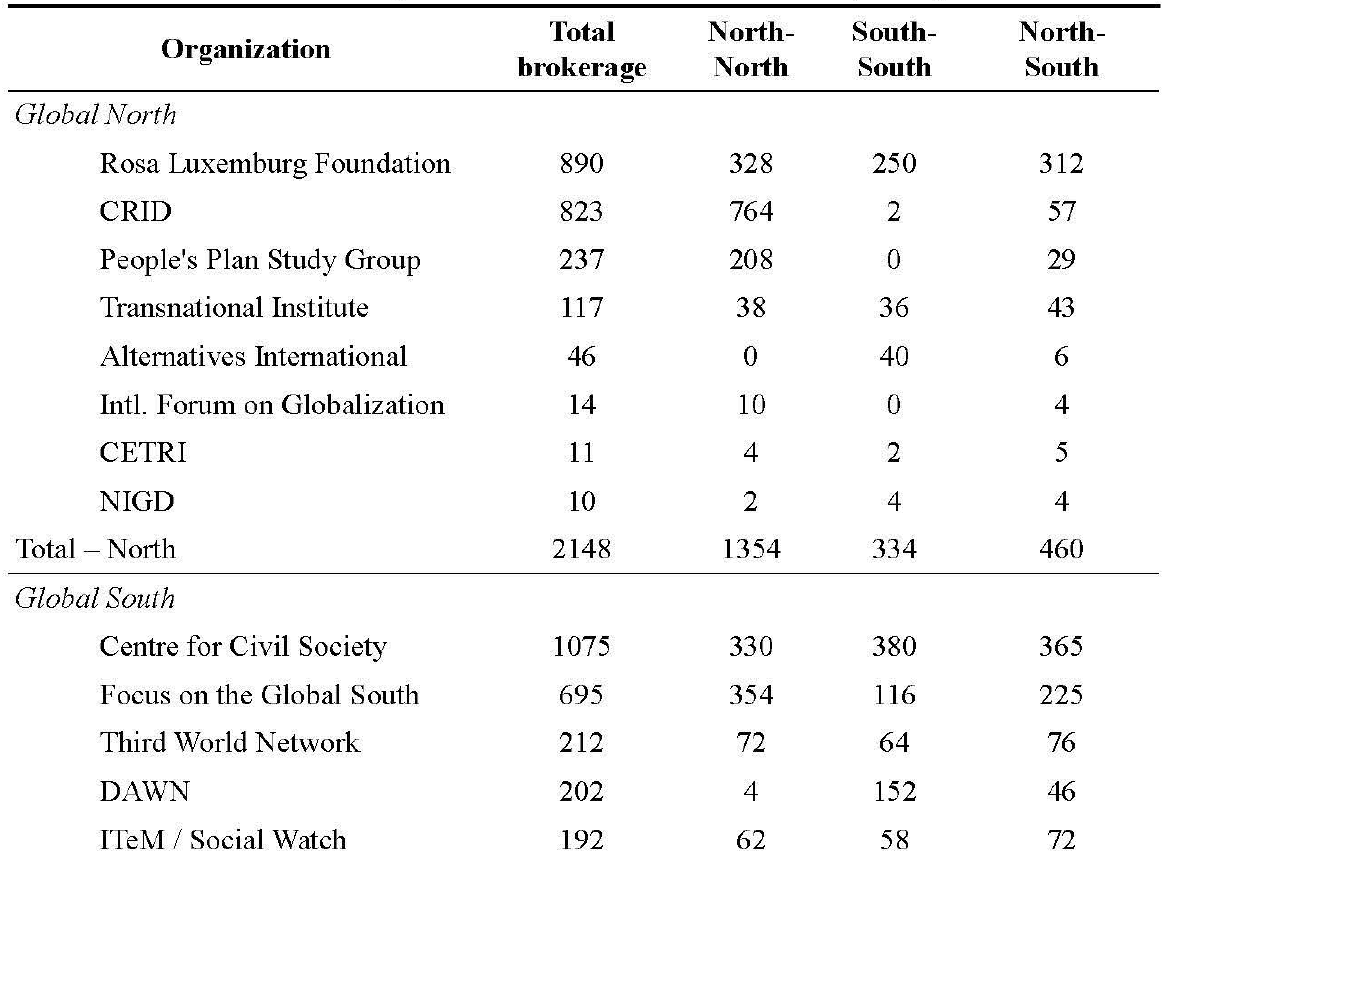
Table 7. Relations brokered by TAPGs between North and South (n=253l Total North- South- North- Organization brokerage North South